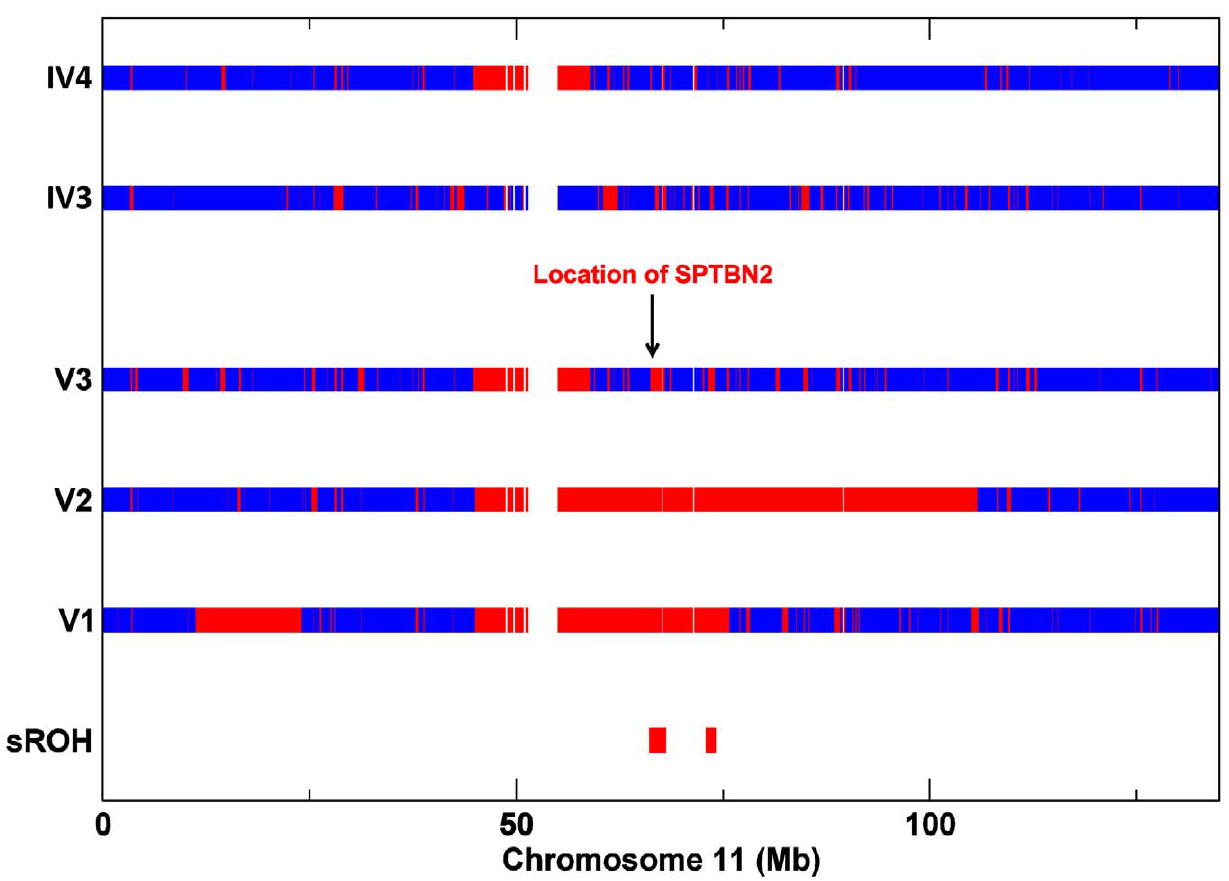
Figure 3. SNP Zygosity data for chromosome 11 from affecteds V1, V2, V3, and V3’s parents IV3 and IV4. Red lines correspond to homozygous SNPs and blue lines to heterozygous SNPs (the gap represents the